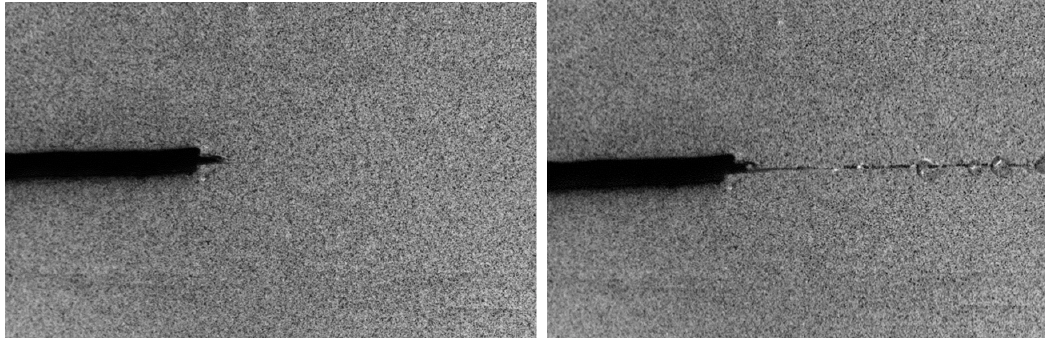
Figure 7. Macroscopic images of ENF 192-1 specimen before ( left ) and after ( right ) crack propagation.